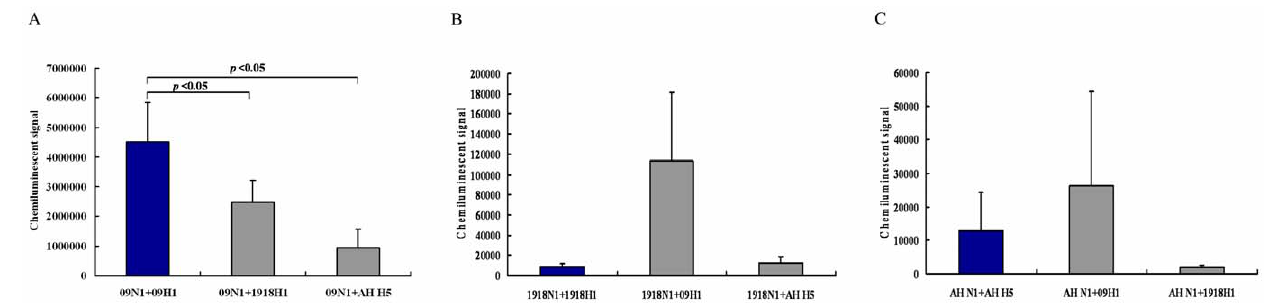
Figure 4. NA activity in the various pps, NA activity is presented as the Mean 6 SD from 3 repeats. A. NA activity of 09N1 combined with 09H1, 1918H1, and AH H1. B. NA activity of 1918N1 combined with 1918H1, 09H1, and AH H1. C. NA activity of AH N1 combined with AH H1, 09H1, and 1918H1. doi:10.1371/journal.pone.0009167.g004 binding sites; gray boxes indicate potential glycosylation sites as predicted from the HA1 sequence; and the green box indicates the residues corresponding to the active site of NA (Fig. 5).